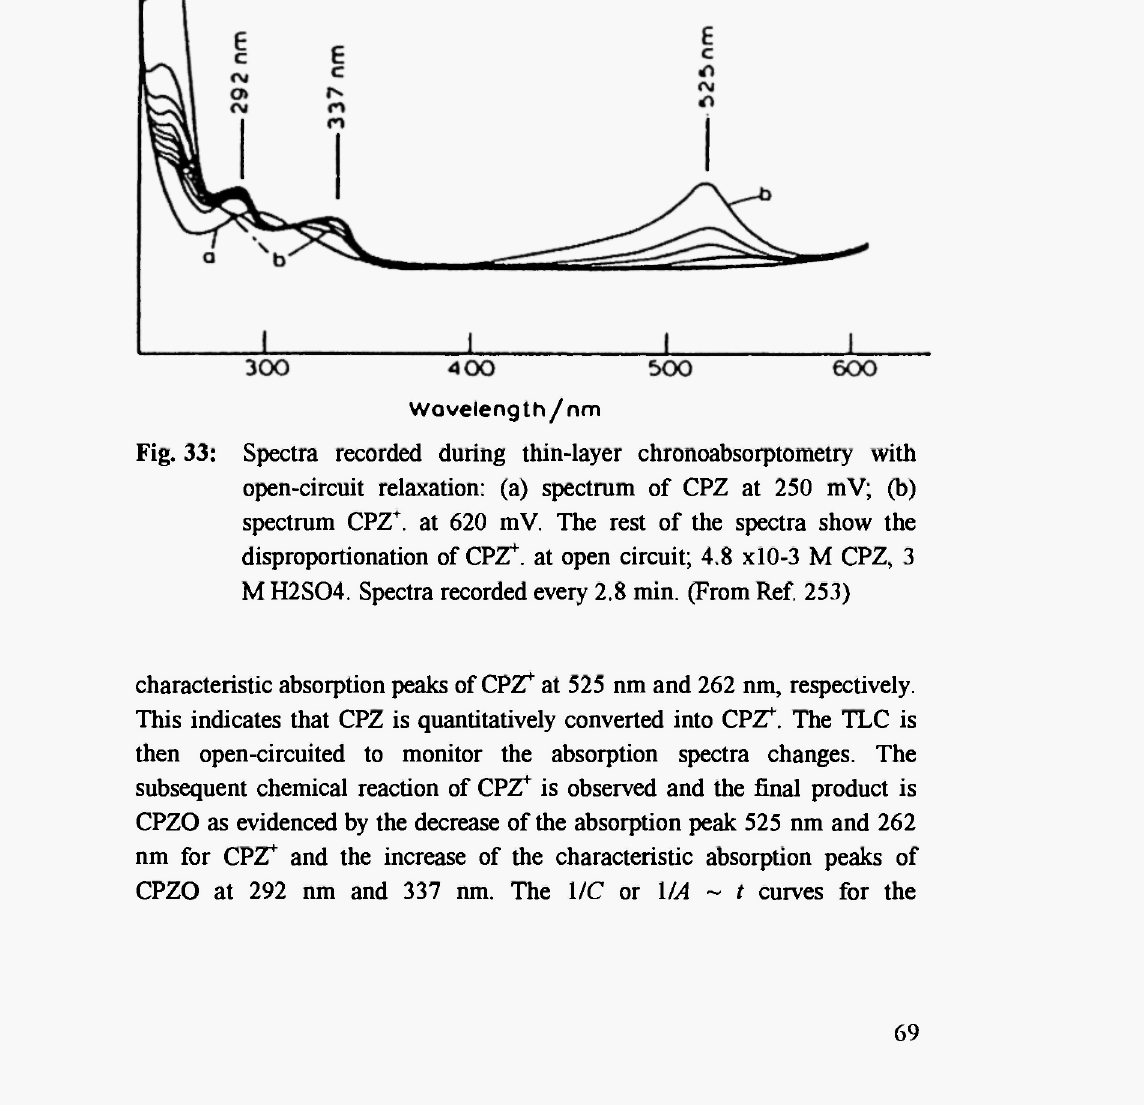
Fig. 33: Spectra recorded during thin-layer chronoabsorptometry with open-circuit relaxation: (a) spectrum of CPZ at 250 mV; (b) spectrum CPZ + . at 620 mV. The rest of the spectra show the disproportionation of CPZ + . at open circuit; 4.8 χ 10-3 Μ CPZ, 3 Μ H2S04. Spectra recorded every 2.8 min. (From Ref. 253)